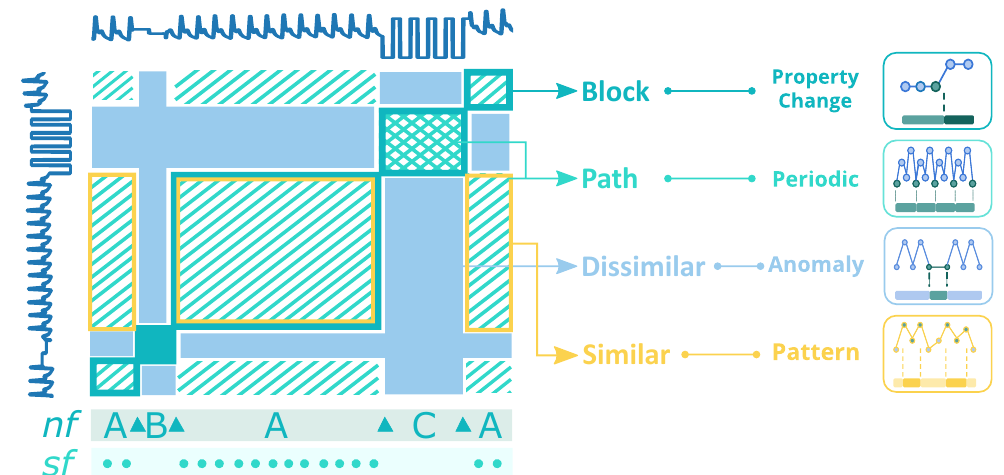
Figure 4. The informative structures of an ABP signal’s SSM. The three main structures are highlighted in the simplified illustration: A—the homogeneous segments corresponding to periods in the ABP signal; B—the homogeneous segment representing missing data; C—the homogeneous segment cueing sensor detachment. The “blocks” in the figure accentuate homogeneous behaviour, while the paths in the figure depict periodicity in the segment. Segment C has a cross pattern, which symbolizes periodicity and symmetry. nf : novelty function; sf : similarity function; (cid:52) : change points separating blocks A, B and